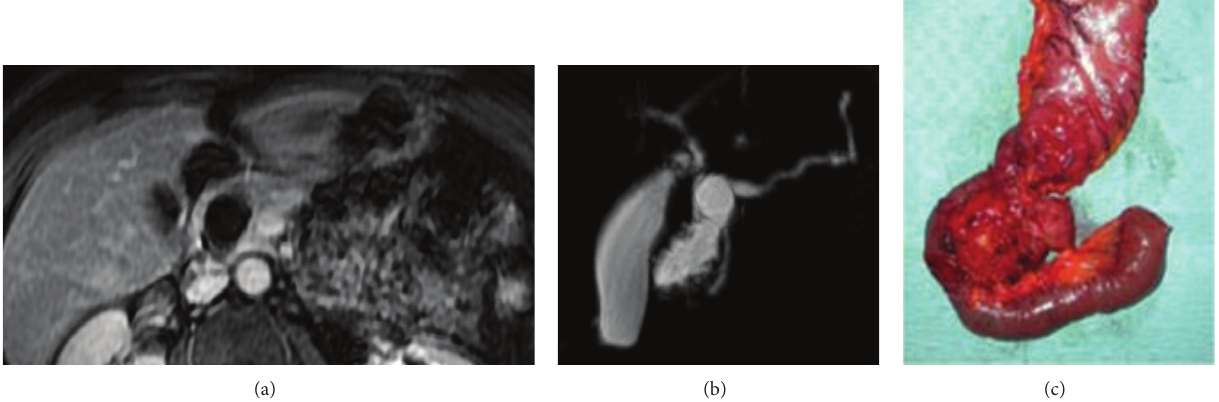
Figure 4: Axial T1-weighted spoiled gradient echo after gadolinium administration (a). 3D FRFSE MRCP sequence obtained using MIP reconstruction (b). Surgical specimen (c), from poster EPOS C-2228 presented in [15]. (a) shows a homogeneous cystic lesion centered in the head of pancreas. No intralesion solid components were observed. In (b), MIP reconstruction was useful to better appreciate the cystic morphology of the lesion due to main pancreatic duct enlargement. Again, high-risk stigmata (main duct caliber > 1 centimeter) suggested surgical management. A pancreatoduodenectomy was performed and final diagnosis deposed for borderline